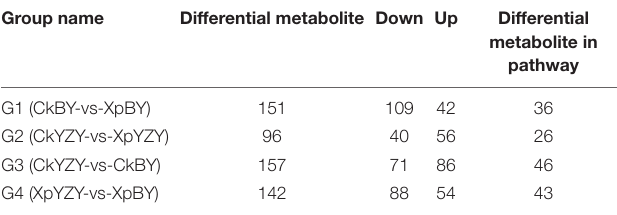
TABLE 1 | Differential metabolites between different treatment groups of oat roots.